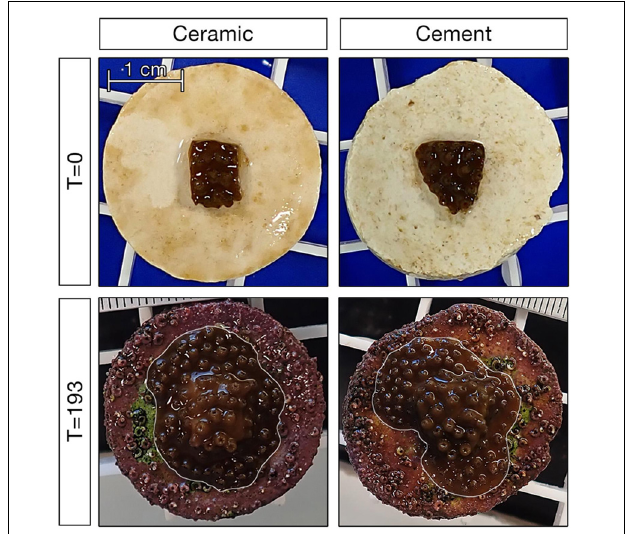
FIGURE 1 | Example of corals on ceramic and cement plugs at the start and end of the 193 day experiment. Corals in the bottom panels are outlined in white to differentiate them from fouling organisms on the